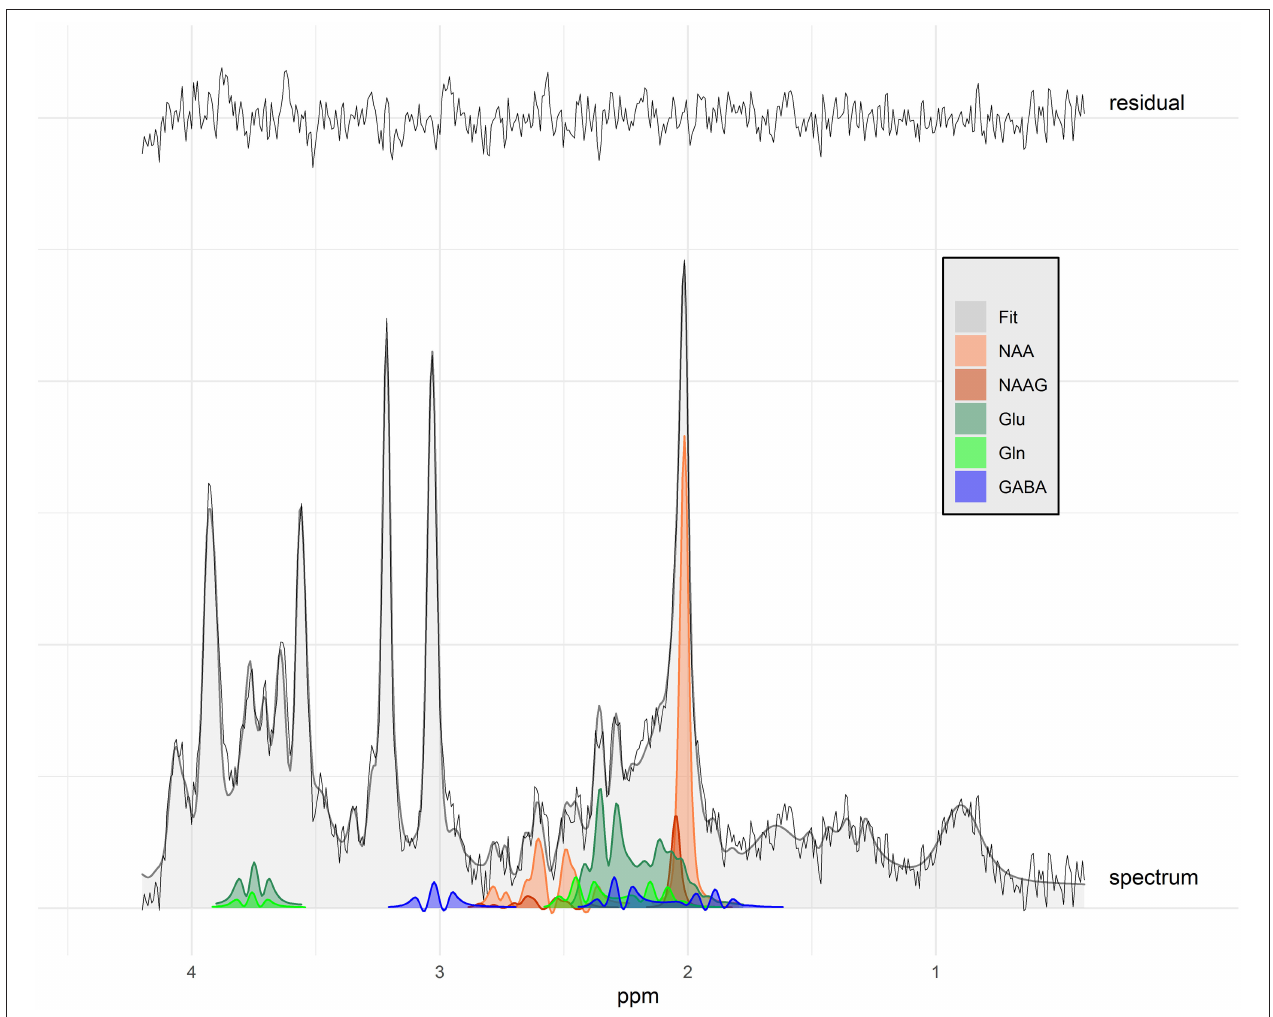
FIGURE 2 | Spectrum with signal-to-noise ratio of 16 (study mean: 12.9) and water peak full width at half maximum of 6.8Hz (study mean: 6.79Hz) of an idiopathic epileptic dog with antiepileptic drug treatment. The black line shows the acquired data, the gray area the overall fit, and the colors the individual fit components displayed for selected metabolites. Fit residuals are shown at the top. NAA, N-acetyl aspartate; NAAG, N-acetylaspartylglutamate; Glu, glutamate; Gln, glutamine; GABA,